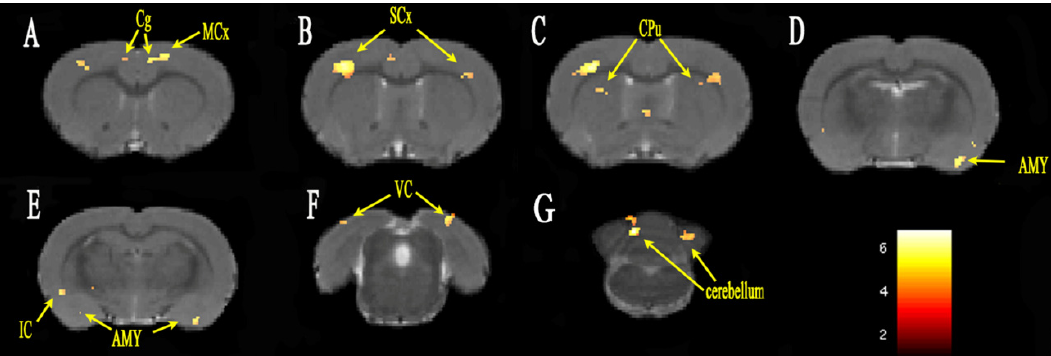
Figure 2. FC alterations in specific brain regions of PHN rats on day 7 ( A – G ). ROI heat maps show the brain regions with significantly increased FC. The color scale bar is shown in lower-right part, with corrected t -values ranging from 2 to 6. Cg, cingulate gyrus; MCx, motor cortex; SCx, sensory cortex; CPu, caudate putamen; IC, insular cortex; AMY, amygdala; VC, visual cortex; cerebellum. Table 1. The group differences of FC changes between PHN group and CON group on Day 7. Coordinates of Peak Voxel Brain Region Cluster Size t -Value X Y